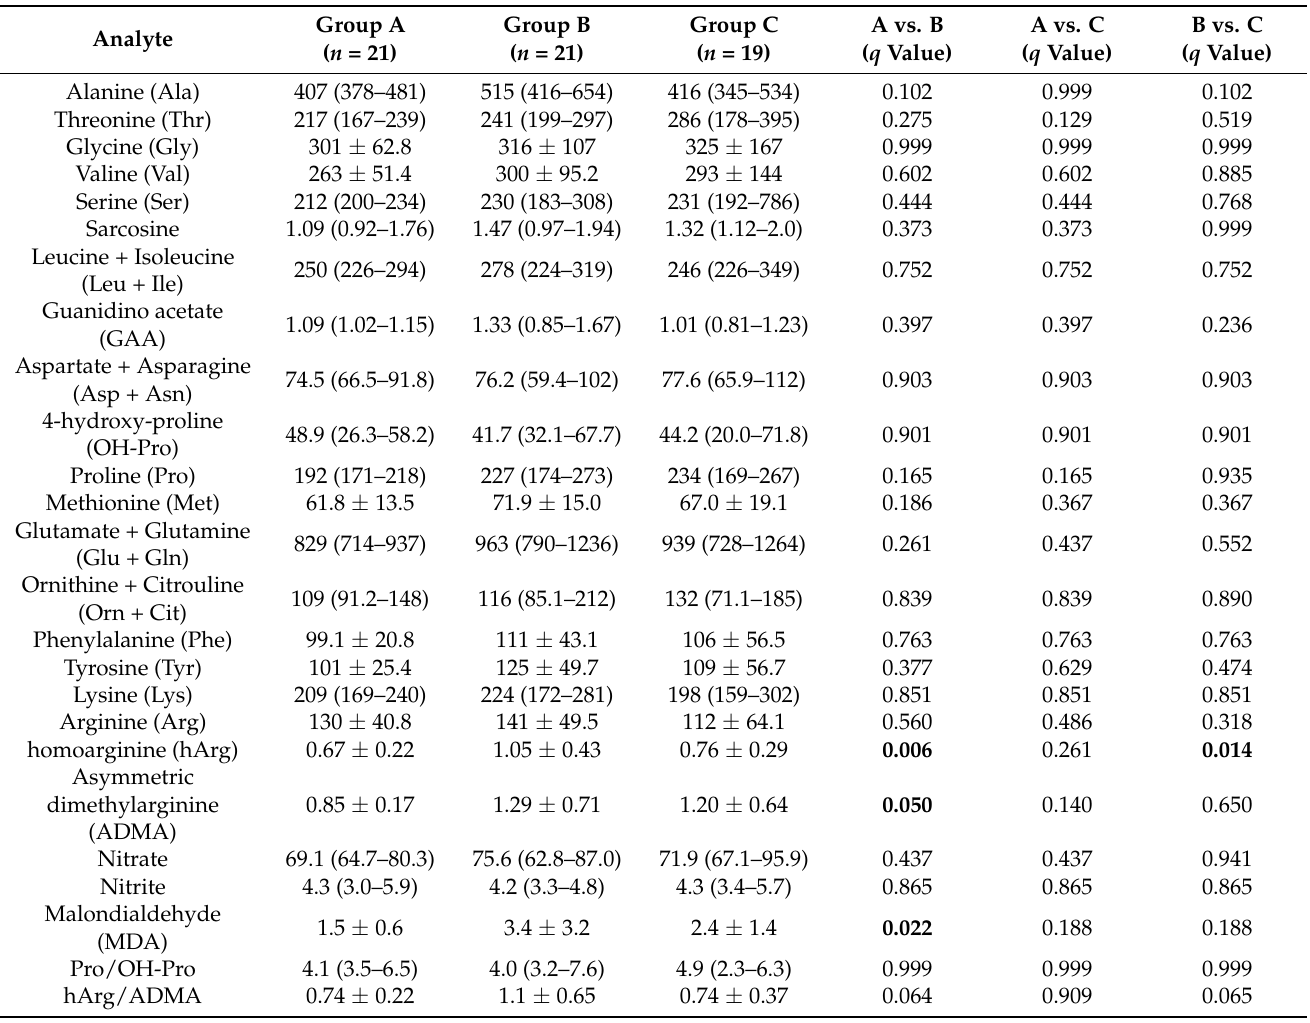
Table 2. Serum concentrations ( µ M) a of the analytes and serum molar ratios of Pro/OH-Pro and hArg/ADMA in the examined